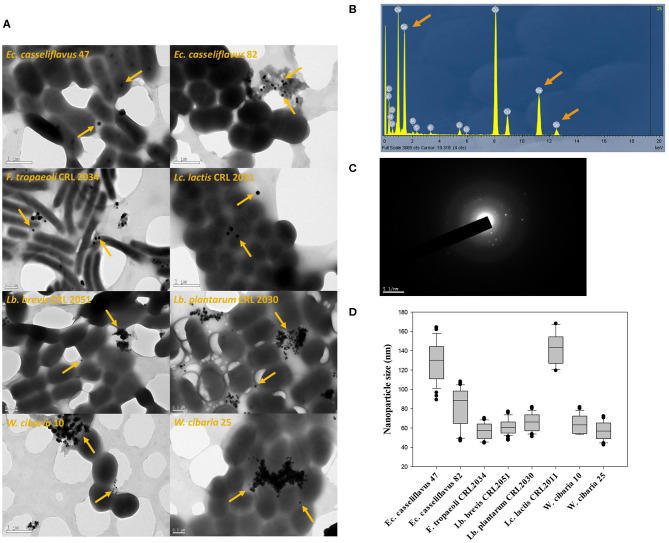
TEM images and XEDS analysis obtained for samples of eight selected strains grown in MRS/MRSf supplemented with 5 ppm Se at 30°C for 24 h. (A) TEM images of eight LAB strains; orange arrows indicate the presence of isolated or gathered nanoparticles. (B) X-Ray Energy Dispersive Spectroscopy (XEDS) analysis graph depicting energy on X-axis and number of counts on Y-axis representing elemental composition derived from selenium nanoparticles. Arrows in XEDS spectra indicate the Se emission peaks consisting of SeLα, SeKα, and SeKβ at 1.4, 11.22, and 12.49 keV, respectively. (C) Diffraction pattern of nanoparticles. (D) Nanoparticle size distribution (n = 100) of eight selected strains.